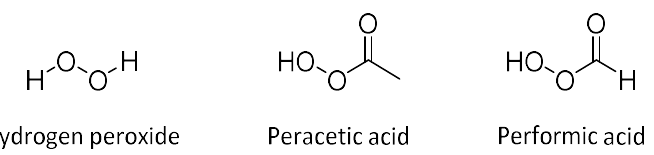
Figure 13. Structures of biocides peroxigen compounds.